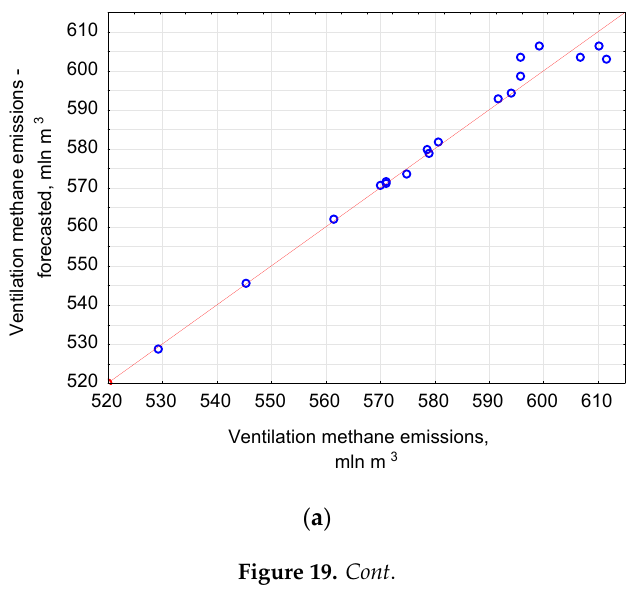
( a ) Figure 19. Cont